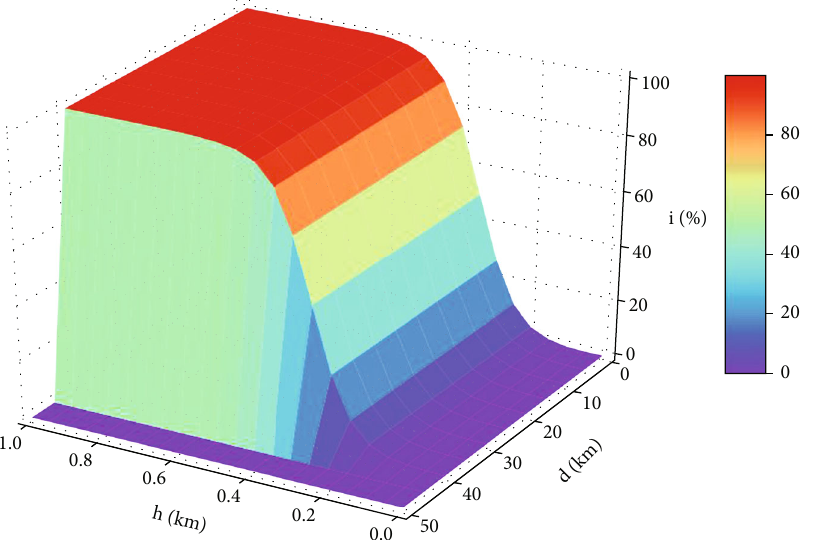
Figure 3: Radar detection probability